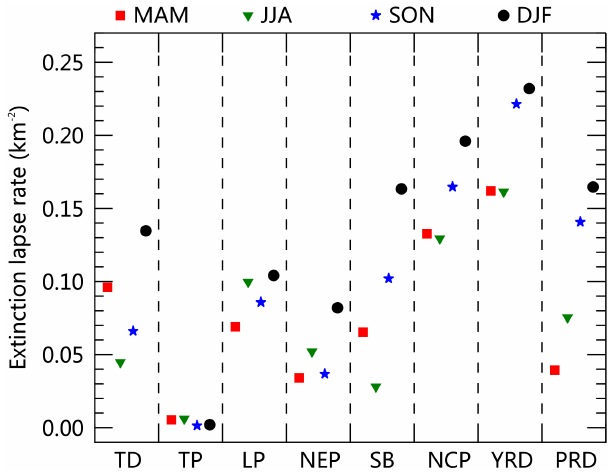
Figure 11. Extinction lapse rates within 1.5km above the ground. For the profiles where the extinction maximum is not reached at the bottom (such as the profiles for the Sichuan Basin because of the topography), the extinction lapse rates are calculated within 1.5km above the height of the maximum